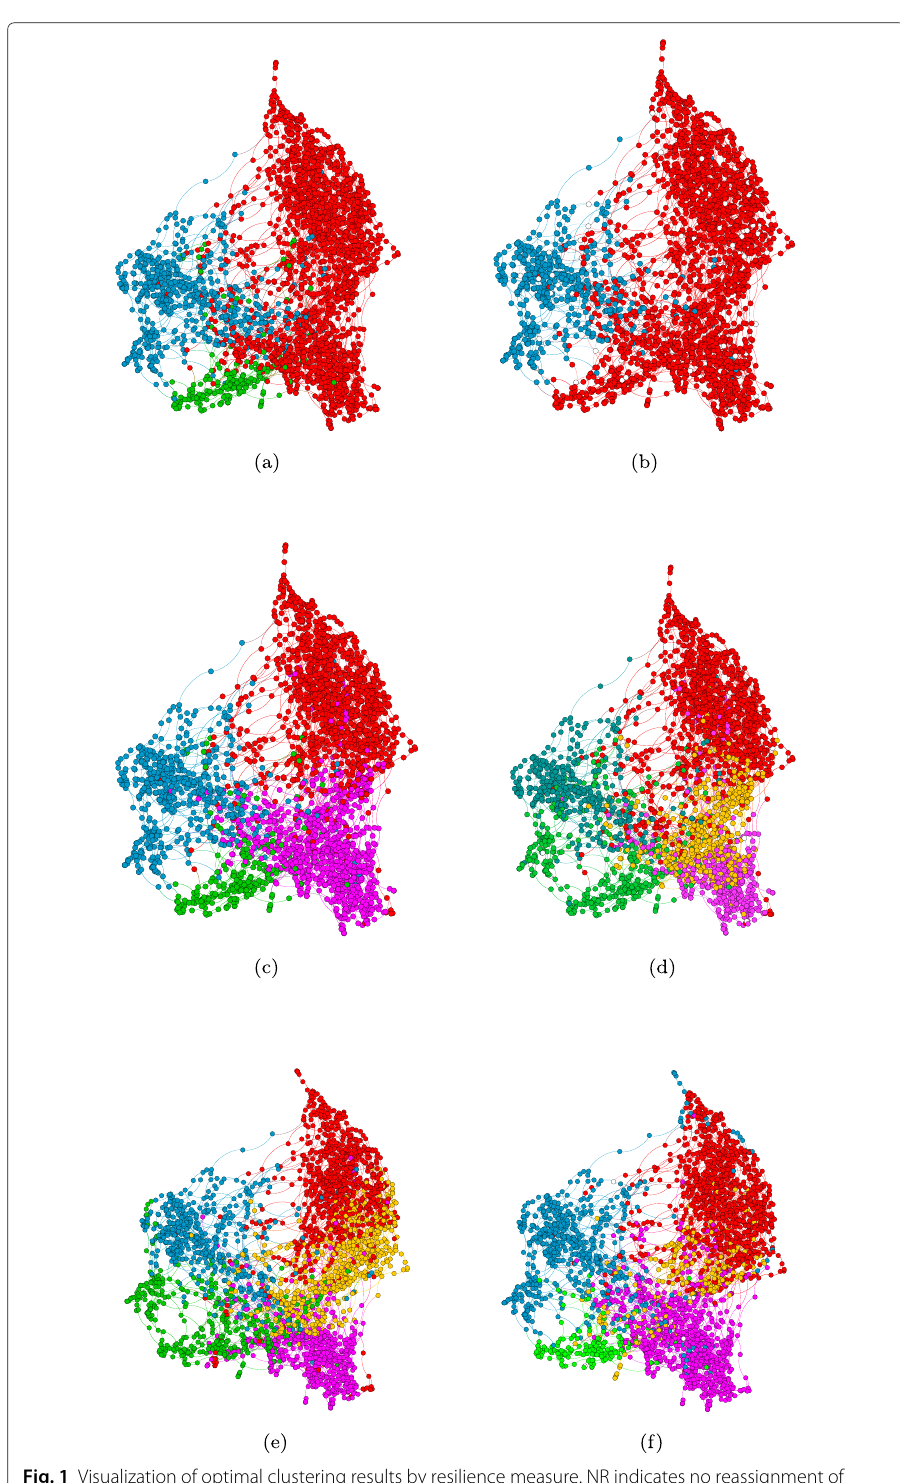
Fig. 1 Visualization of optimal clustering results by resilience measure. NR indicates no reassignment of attack set nodes. a kNN2 Integrity k = 3. Red nodes denotes C0, Blue: C2, and Green: C1. b kNN2 VAT k = 2 NR. Red nodes denotes C0, and Blue: C1. c kNN2 VAT k = 4. Red nodes de- notes C2, Blue: C3, Purple: C0, and Green: C1. d kNN2 Integrity k = 5 NR. Red nodes denotes C0, Blue: C2, Gold: C1, Purple: C3, and Green: C4. e kNN2 Tenacity k = 5. Red nodes denotes C2, Blue: C3, Gold: C0, Purple: C1, and Green: C4. f kNN2 Tenacity k = 5 NR. Red nodes denotes C1, Blue: C2, Gold: C3, Purple: C0, and Green: